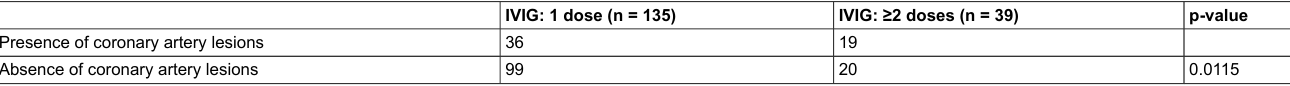
Table 4: Relation between the number of coronary artery lesions and the need for a second dose of intra-venous immunoglobulins. Data are provided as absolute numbers.